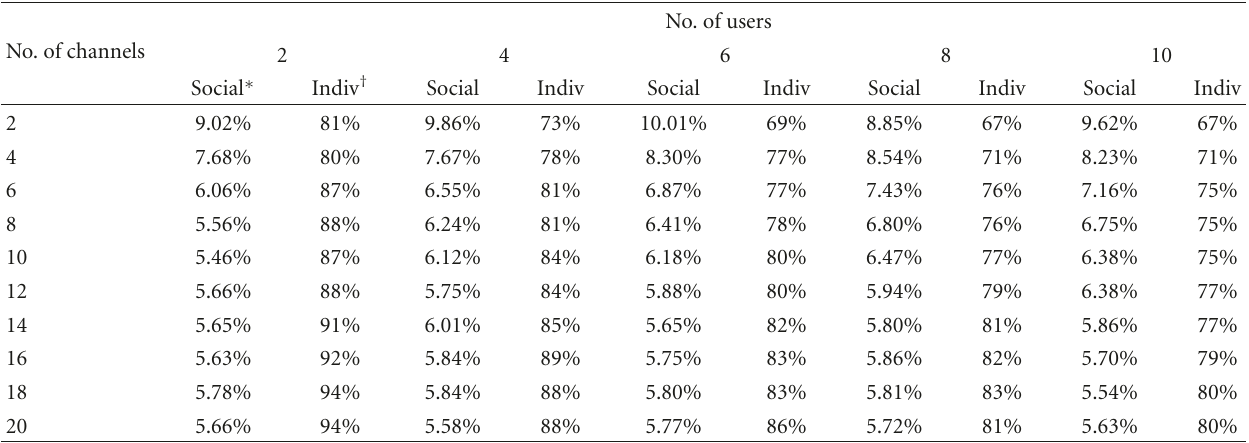
Table 9: Comparisons of social utility and individual utility between competitive equilibrium(CE) with balanced individual utilities and Nash equilibrium(NE) under two tiers of channels, di ff erence tolerance = 0.01 and average of 100 simulation runs.